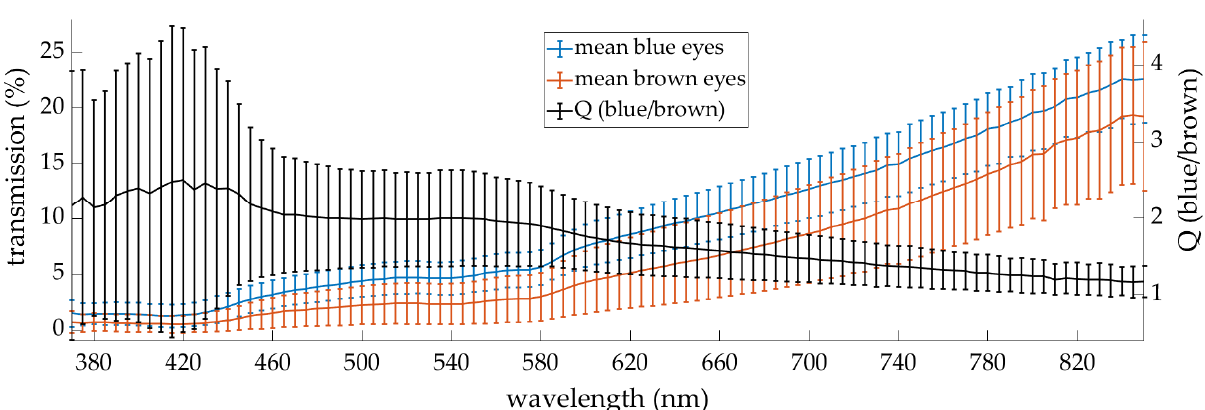
Figure 3. Wavelength-dependent transmission of the porcine eyewall depending on the pigmentation of the eye on the left y ‐ axis and the ratio Q of the transmission of blue eyes to that of brown eyes on the right y ‐ axis with corresponding standard deviation.